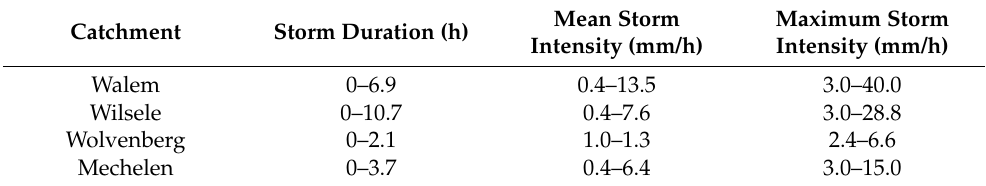
Table A1. Rainfall characteristics of storms during sampling period. The resolution of the rain gauge